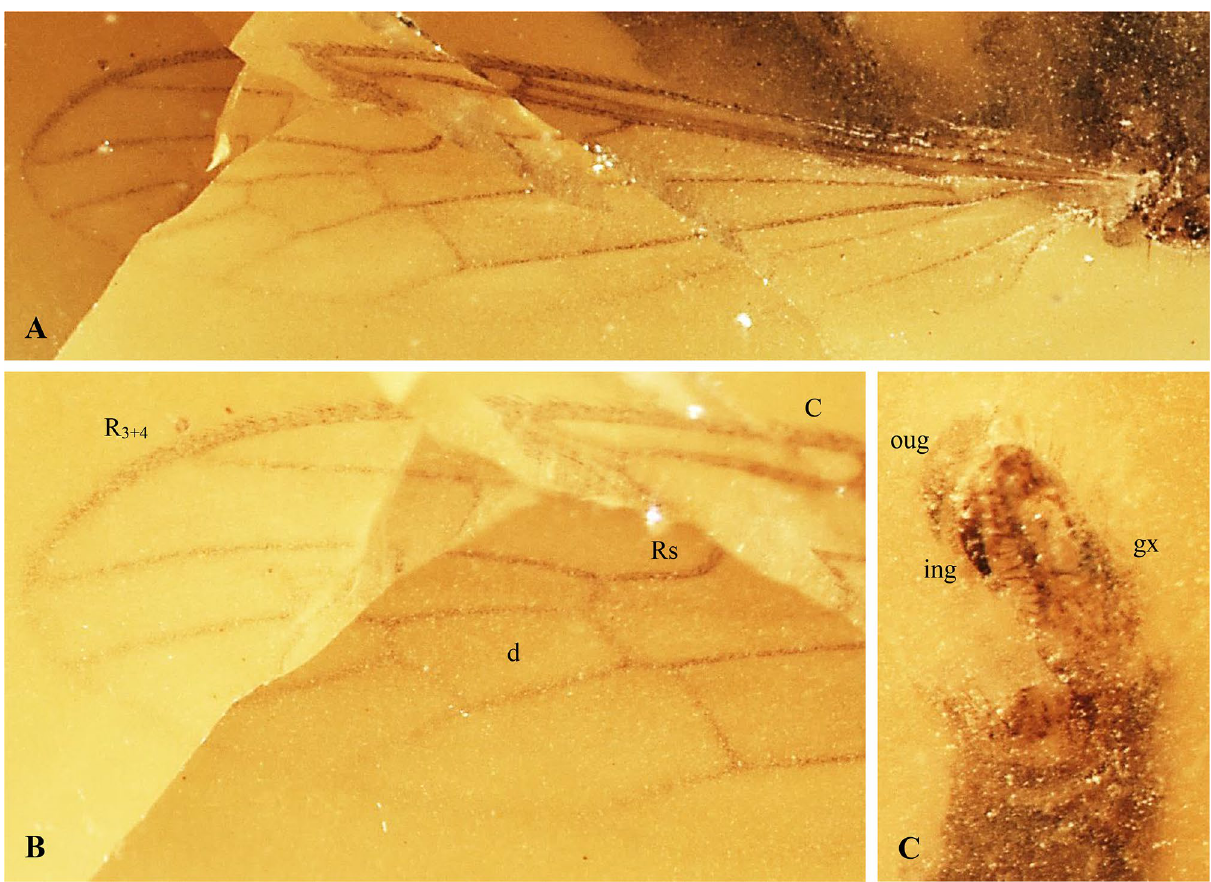
Figure 5. Antodicranomyia rubra sp. nov. No. IGR.CDL-23.1 (male), holotype. ( A ) wing; ( B ) enlarged view of distal half of wing; ( C ) genitalia. Abbreviations as given in Fig.